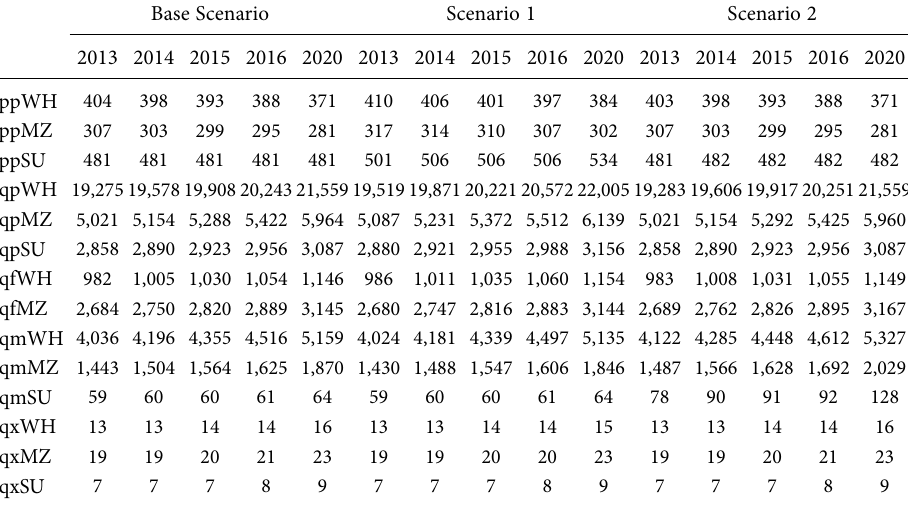
Table A.1. Producer price ($/ton), production, feed demand, total imports, total exports (quantities are in 000